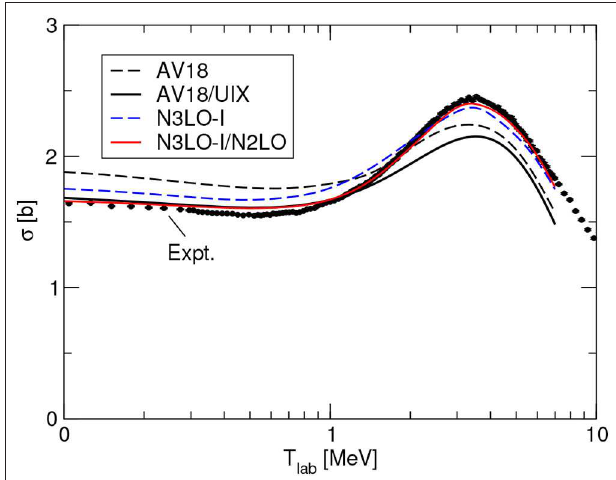
FIGURE 4 | n − 3 H total cross sections calculated with the AV18 (dashed black line), AV18/UIX (solid black line), N3LO-I (dashed blue line), and the N3LO-I/N2LO (solid red line) potential models as function of the incident neutron laboratory energy E n . The experimental data are from reference [ 91].